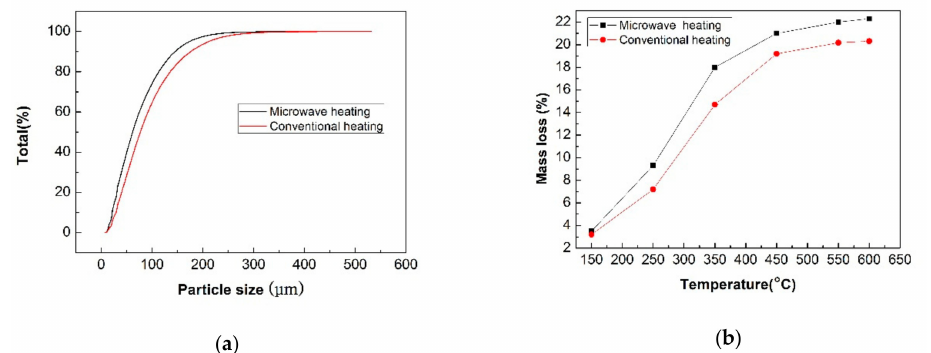
Figure 9. Changes in basic physical properties. ( a ) Particle size distribution of the products roasted at 450 ◦ C for 10 min by microwave and conventional heating and ( b ) variation of mass loss after microwave and conventional roasting at di ff erent temperature for 10 min.